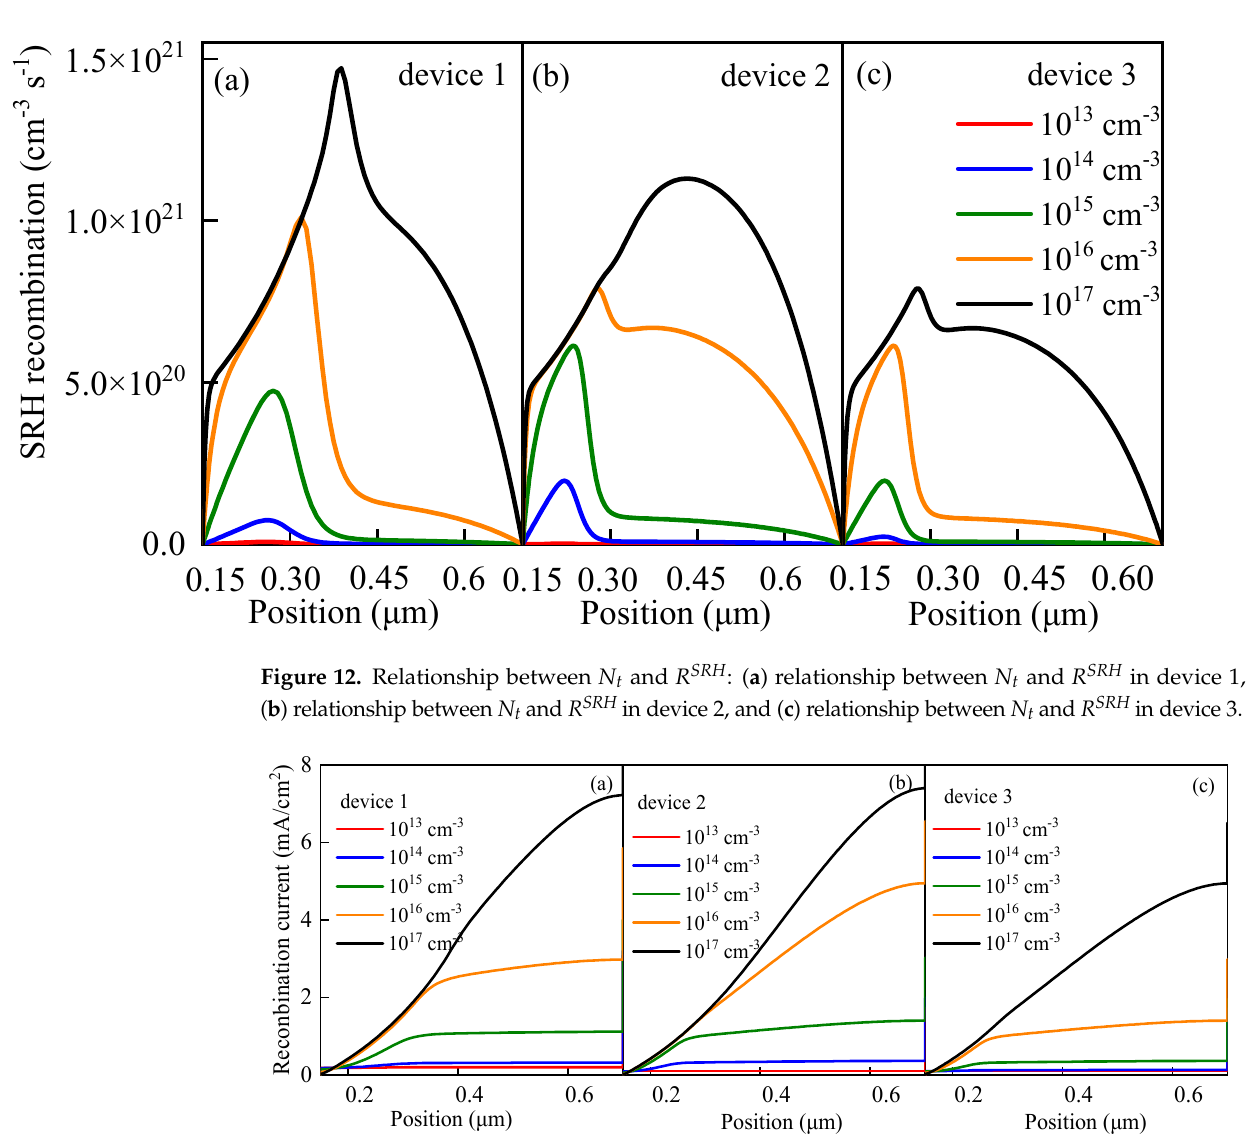
in N t . By contrast, the J-V characteristic curve of device 1 shows the highest sensitivity to the change in N t . All these observations explain that when N t changes in the same range, the performance of device 1 changes greatly, while the performance of device 3 is relatively